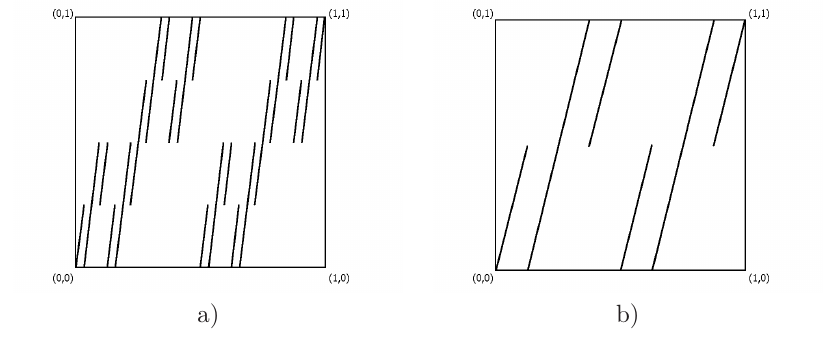
Figure 2. The graph of function in [0;1] that corresponds to: a) increasing mapping that "forgets" first, third and fifth symbols of the sequence, b) increasing mapping that "forgets" first, second and fourth symbols of the